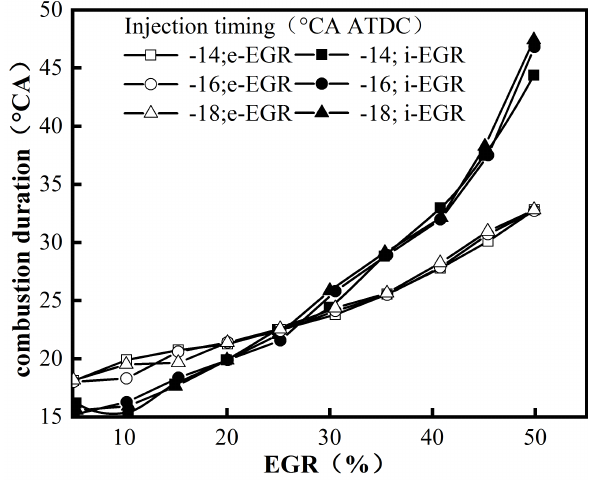
Fig. 6 Effects of i-EGR and e-EGR ratios on combustion duration.